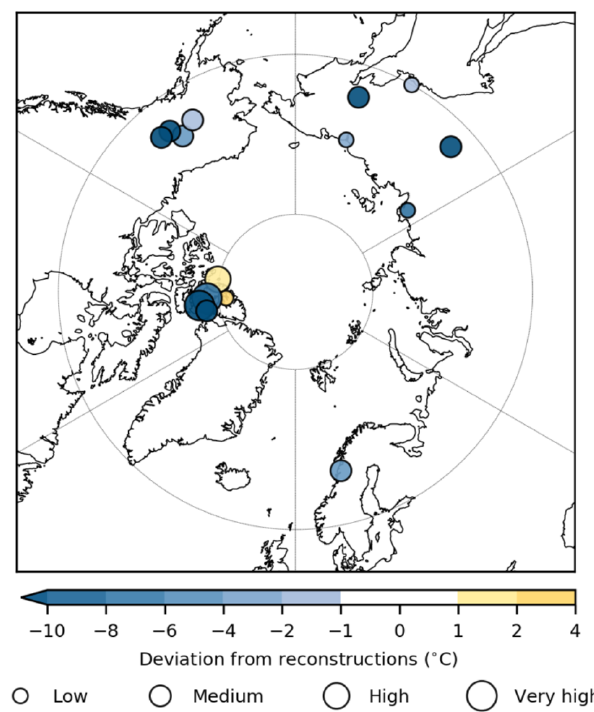
Figure 7. Point-to-point comparison of MMM and reconstructed SAT. The size of SAT reconstructions is scaled by qualitatively as- sessed confidence levels (Salzmann et al., 2013). Data markers for reconstructions in close proximity of each other have been slightly shifted for improved visibility.